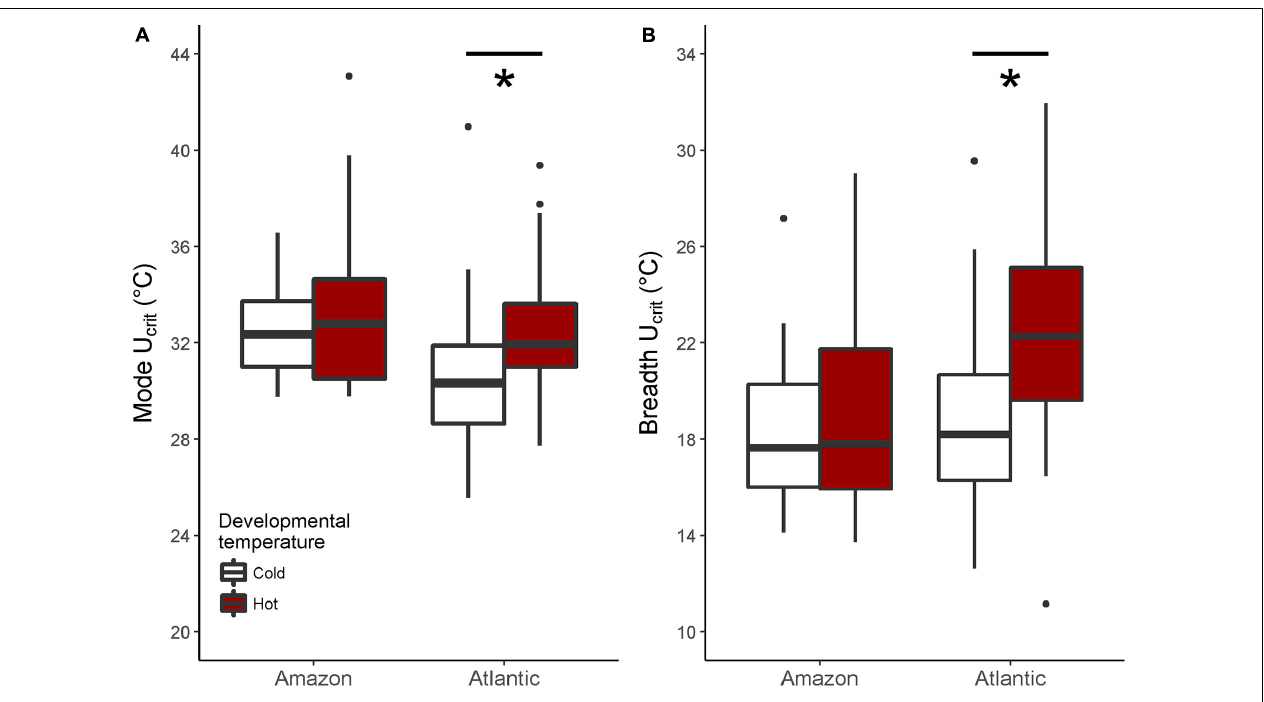
FIGURE 3 | Mode and breath of the thermal performance curves. In Atlantic mollies, different developmental temperatures shifted the mode (i.e., the temperature at which maximal swimming performance occurred) significantly (A) and increased the performance breadth (i.e., 80% maximal performance) (B) . Shown are boxplots where the box indicates the upper and lower quartiles, the dark middle line indicates the median, the whiskers indicate 1.5 times the inter-quartile range and asterixes denote significant differences. There were no significant effects of developmental temperature on performance curve mode or breadth in clonal Amazon mollies. Any values outside that range are shown as points. N = 26, 24 for cold, hot Atlantic mollies, respectively; and N = 28, 31 for cold, hot Amazon mollies